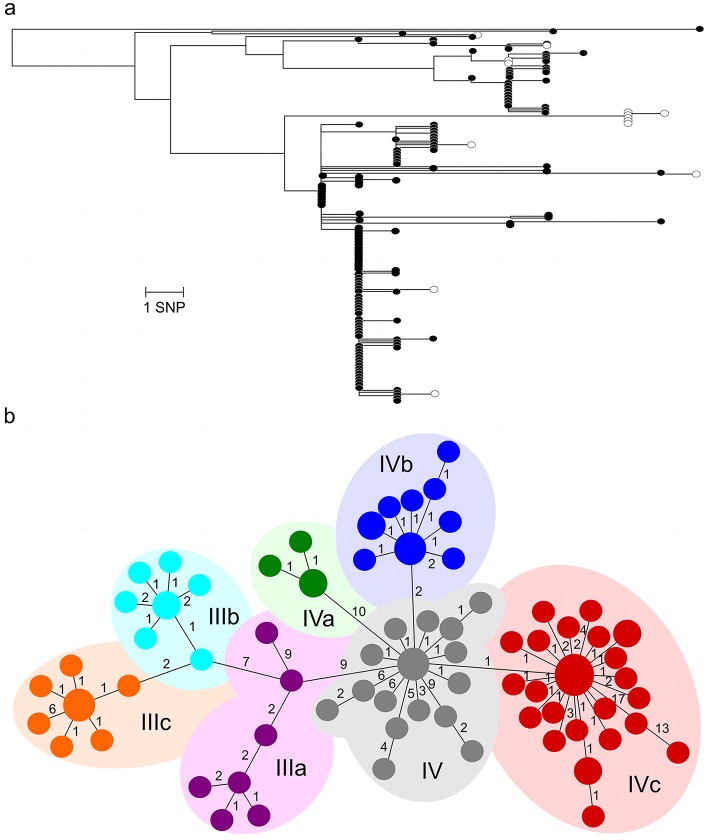
The phylogenetic structure of the H58 lineage of Cambodian Salmonella Typhi.a) Maximum likelihood phylogenetic tree of the 203 H58 isolates identified during this project (scale bar denotes SNP differences). The sub-lineages are shown on the major branches. Isolates exhibiting a multi-drug resistance (MDR) phenotype are indicated by black nodes. The tree is midpoint-rooted for the purpose of clarity. Bootstrap values >85% are indicated by an asterisk. b) Minimum spanning tree subdividing H58 lineage III and IV into the various sublineages (IIIa, IIIb, IIIc, IV, IVa, IVb, IVc). The various sublineages are color-coded for reference and the number of each variant is indicated by the cluster size. The number on each of the branches signifies the number of SNPs between each cluster.